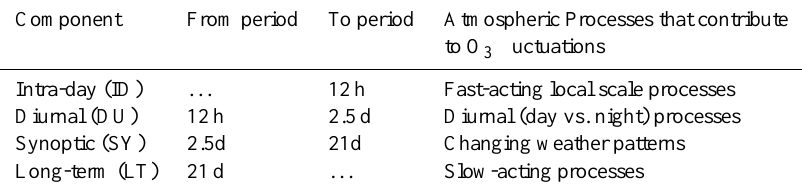
Table 1. Definition of time scales. Component From period To period Atmospheric Processes that contribute